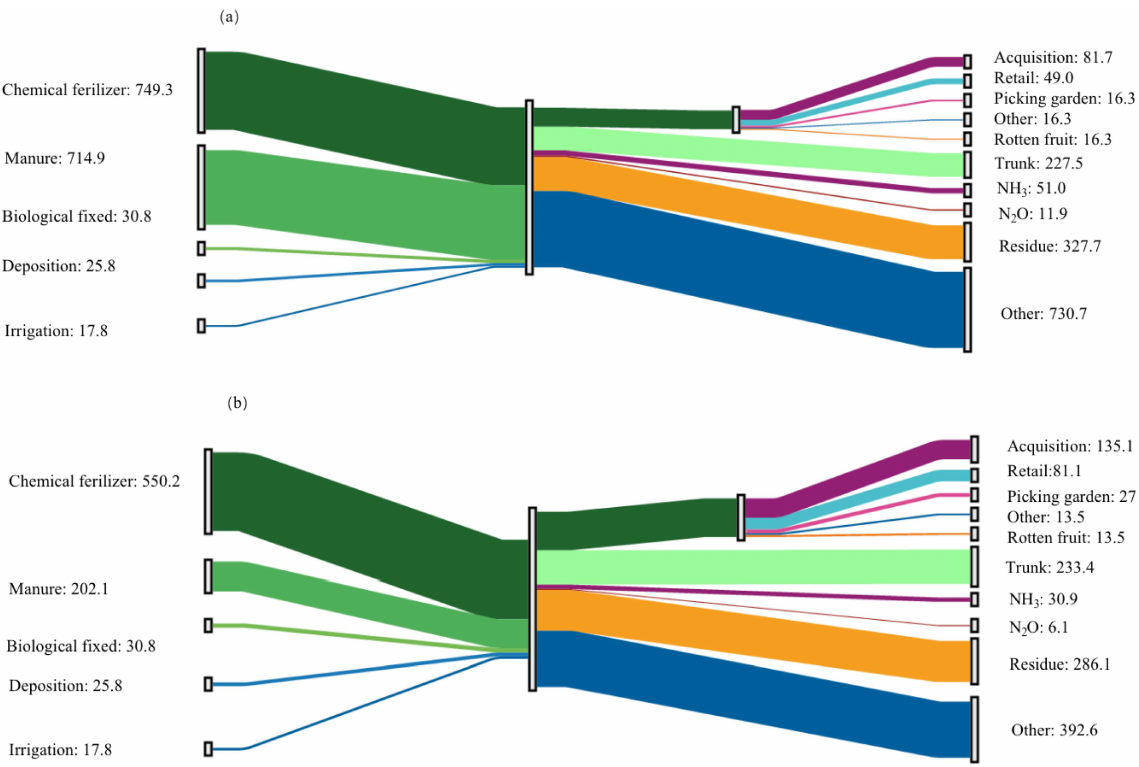
Figure 5. N flow (kg · hm − 2 ) in apple orchards. ( a ) N flow (kg · hm − 2 ) in orchards of TP farmers; ( b ) N flow (kg · hm − 2 ) in orchards of HYHE farmers. The data were based on our 2020 survey of 66 farmers in Xianggongzhuang Village, Quzhou County, Handan city, Hebei Province. The quarter method was used to evaluate 17 apple orchards run by HYHE